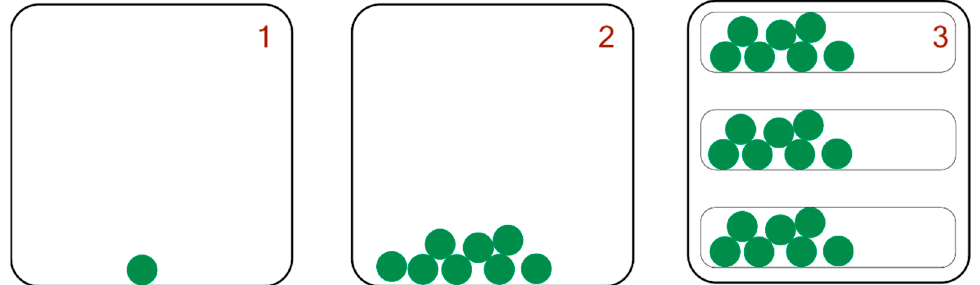
Figure 1. Concepts of traditional particle dampers : 1 - impact damper; 2 - particle damper; 3 - multi-unit particle damper.